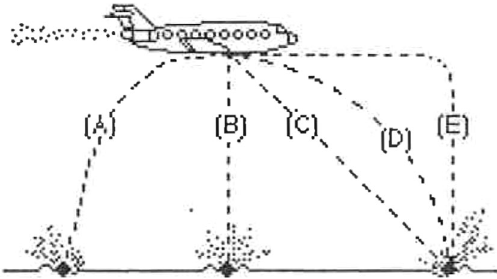
FIG. 2. FCI question 14 [1]. A plane travels to the right with a velocity of ⃗ v and releases a bowling ball, which it was carrying. Options (A) – (E) indicate potential paths the bowling ball could take while it fall from the plane. The proposed Newtonian ordering for this question is given as E < A < B < C < D.